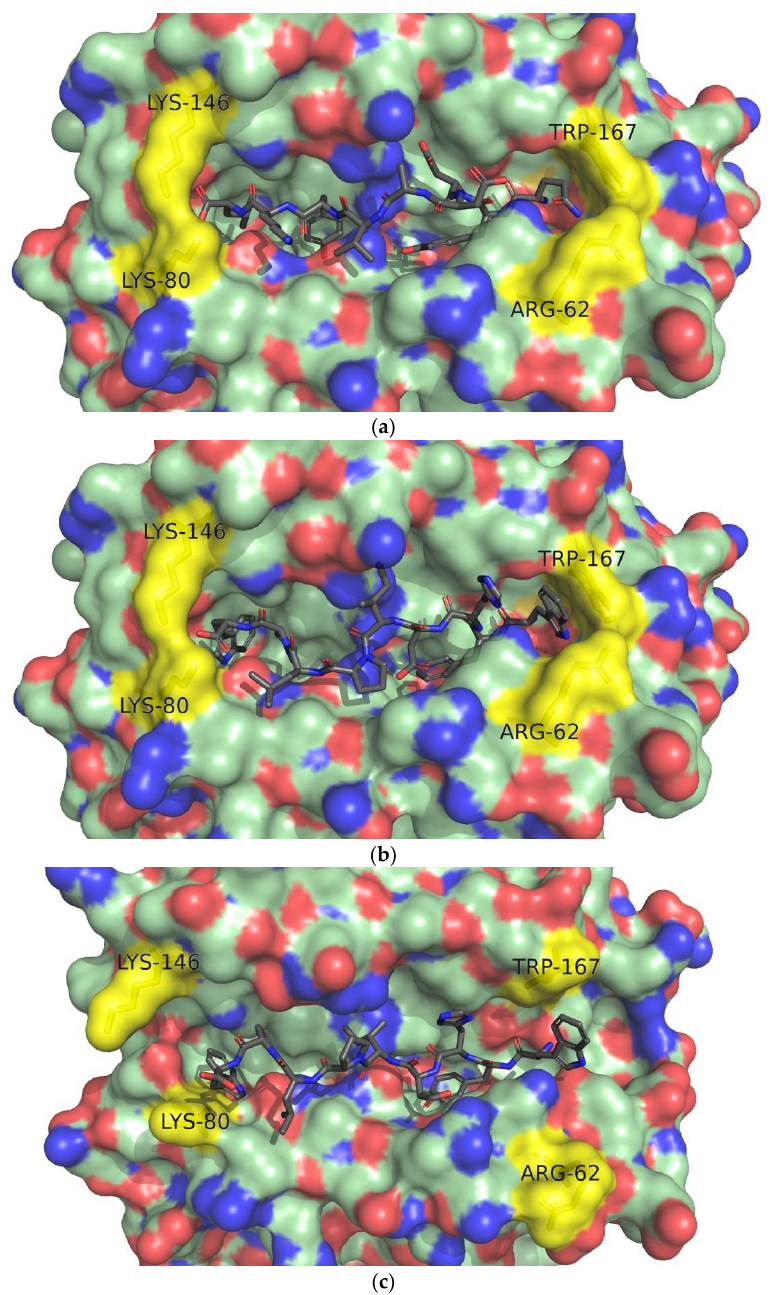
Figure 6. Conformational changes in MD simulation of WFHDIPLPW-HLA-C*04:01. ( a ) HLA-C*04:01 (PDB ID: 1QQD) bound with consensus epitope from pool sequencing (QYDDAVYKL); ( b ) epitope WFHDIPLPW docked to HLA-C*04:01; ( c ) epitope WFHDIPLPW bound to HLA-C*04:01 after 20 ns MD simulation. Epitope residues one to nine are numbered. Residues Arg62, Lys80, Lys146, Trp167 are labeled and colored yellow.